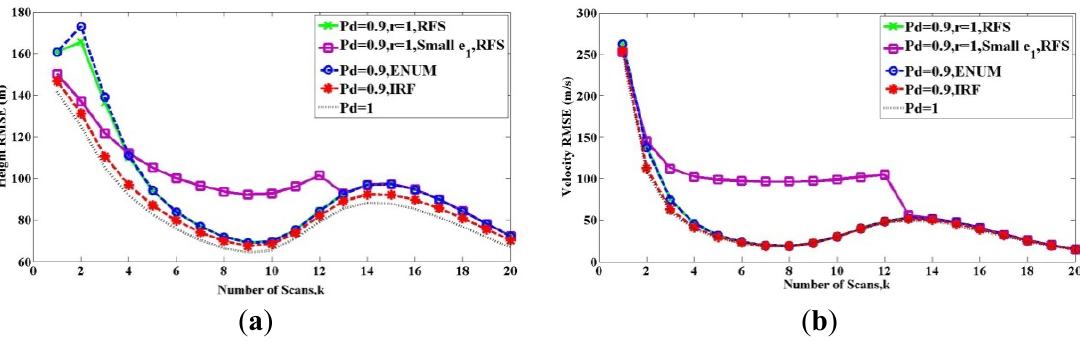
Figure 1. Comparisons of bounds when the target exists from the beginning to the end with different setting cardinality mismatches: ( a ) Height ( b )